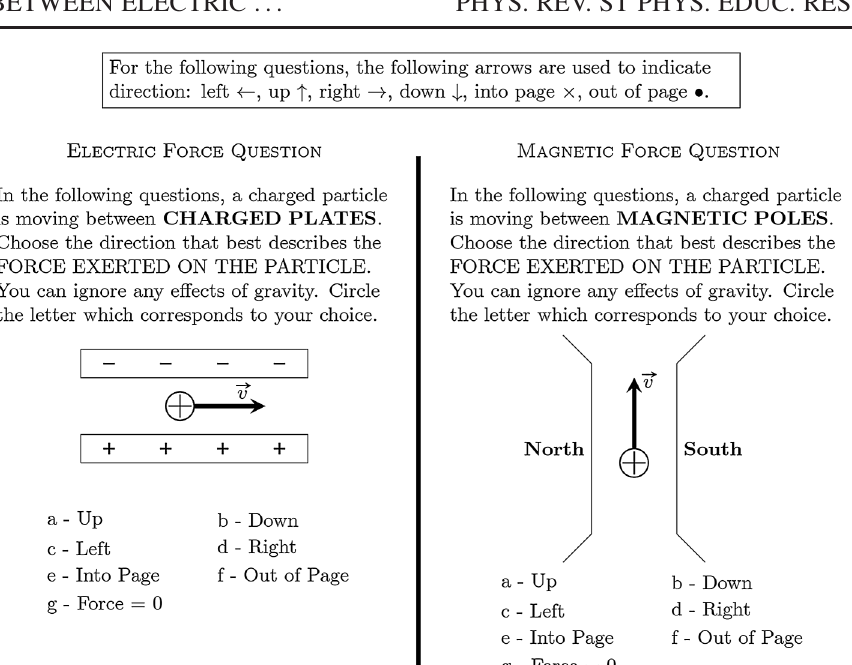
INTERFERENCE BETWEEN ELECTRIC . .